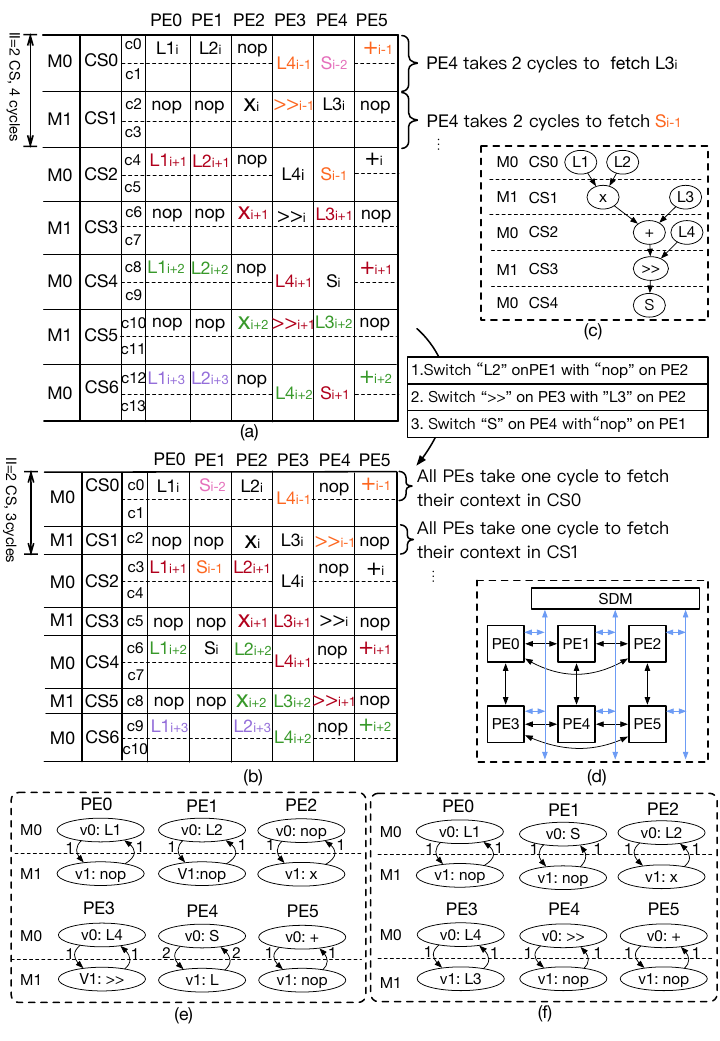
Figure 11. ( a ) The execution scheme of our CGRA under the compilation flow without similarity- aware tuning, ( b ) the execution scheme of our CGRA under the compilation flow with similarity- aware tuning, ( c ) Example DFG, ( d ) the example of our 3 × 2 CGRA, ( e ) context-fetching latency of each PE in every modulo time under the compilation flow without SA tuning, ( f ) context-fetching latency of each PE in every modulo time under the compilation flow with SA